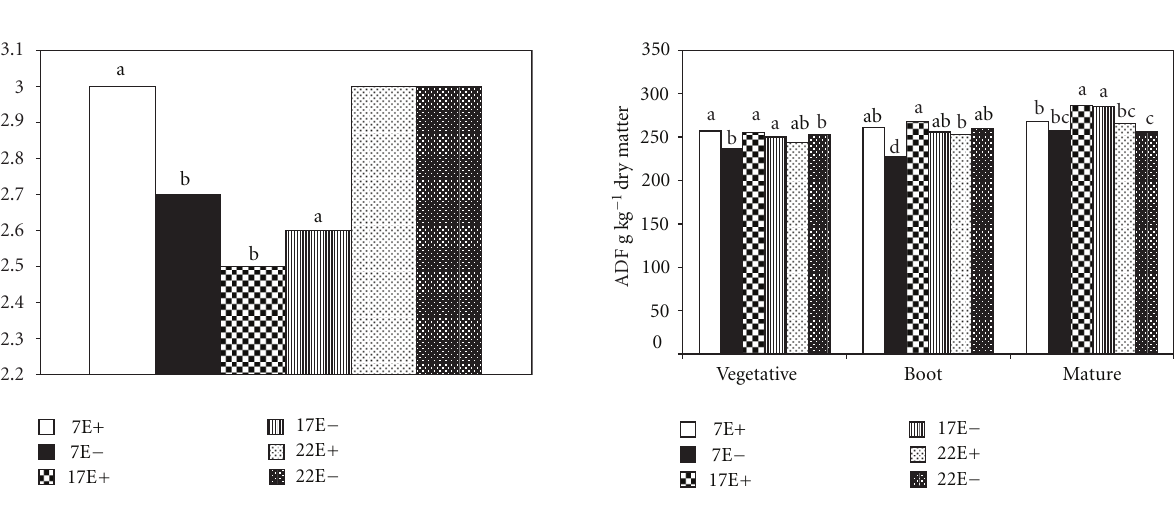
Figure 2: Plant × endophyte e ff ect on gkg − 1 dry matter mean P concentrations from the field. Within plant, bars with di ff erent letters are significantly di ff erent at P = . 05.